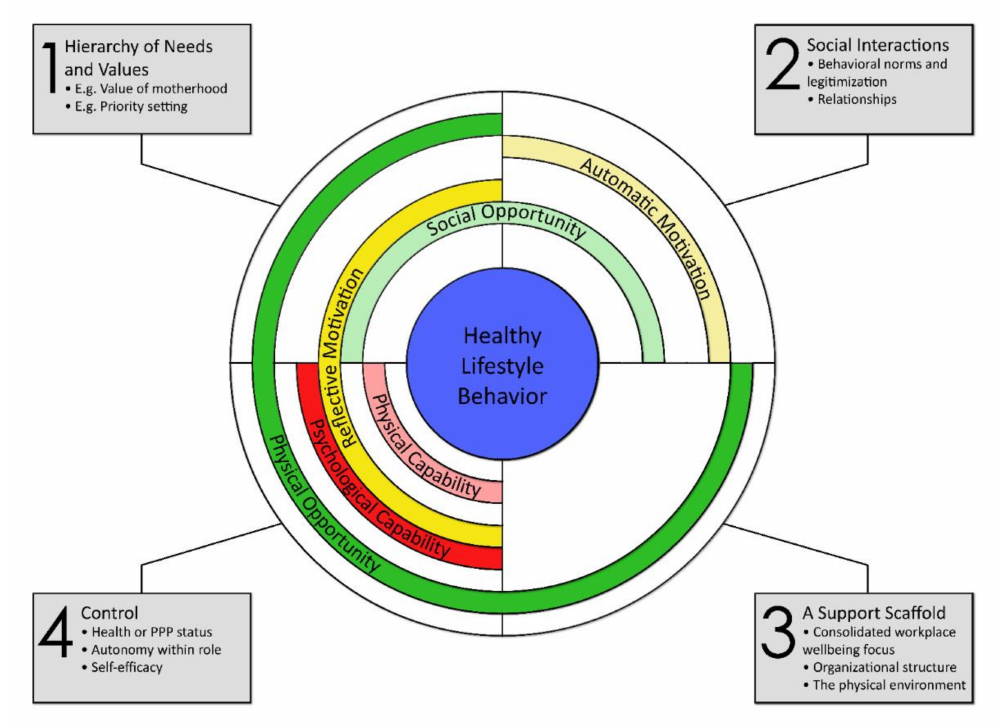
Figure 2. COM-B subcomponents organized according to the four overarching themes. Key: PPP = Preconception, Pregnancy, or